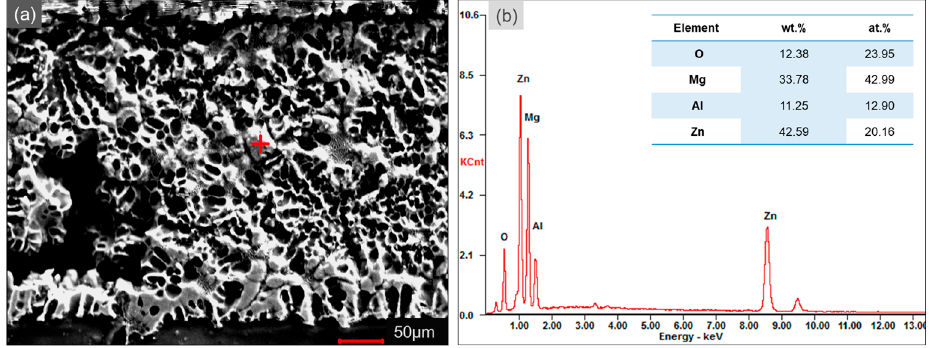
Figure 4. ( a ) The morphology of a cross-section of the intermetallic layer on a surface-alloyed AZ91D magnesium alloy specimen with zinc oxide as the only Zn donor in the diffusion source; ( b ) The EDS result of the point located at the cross marked in ( a ).